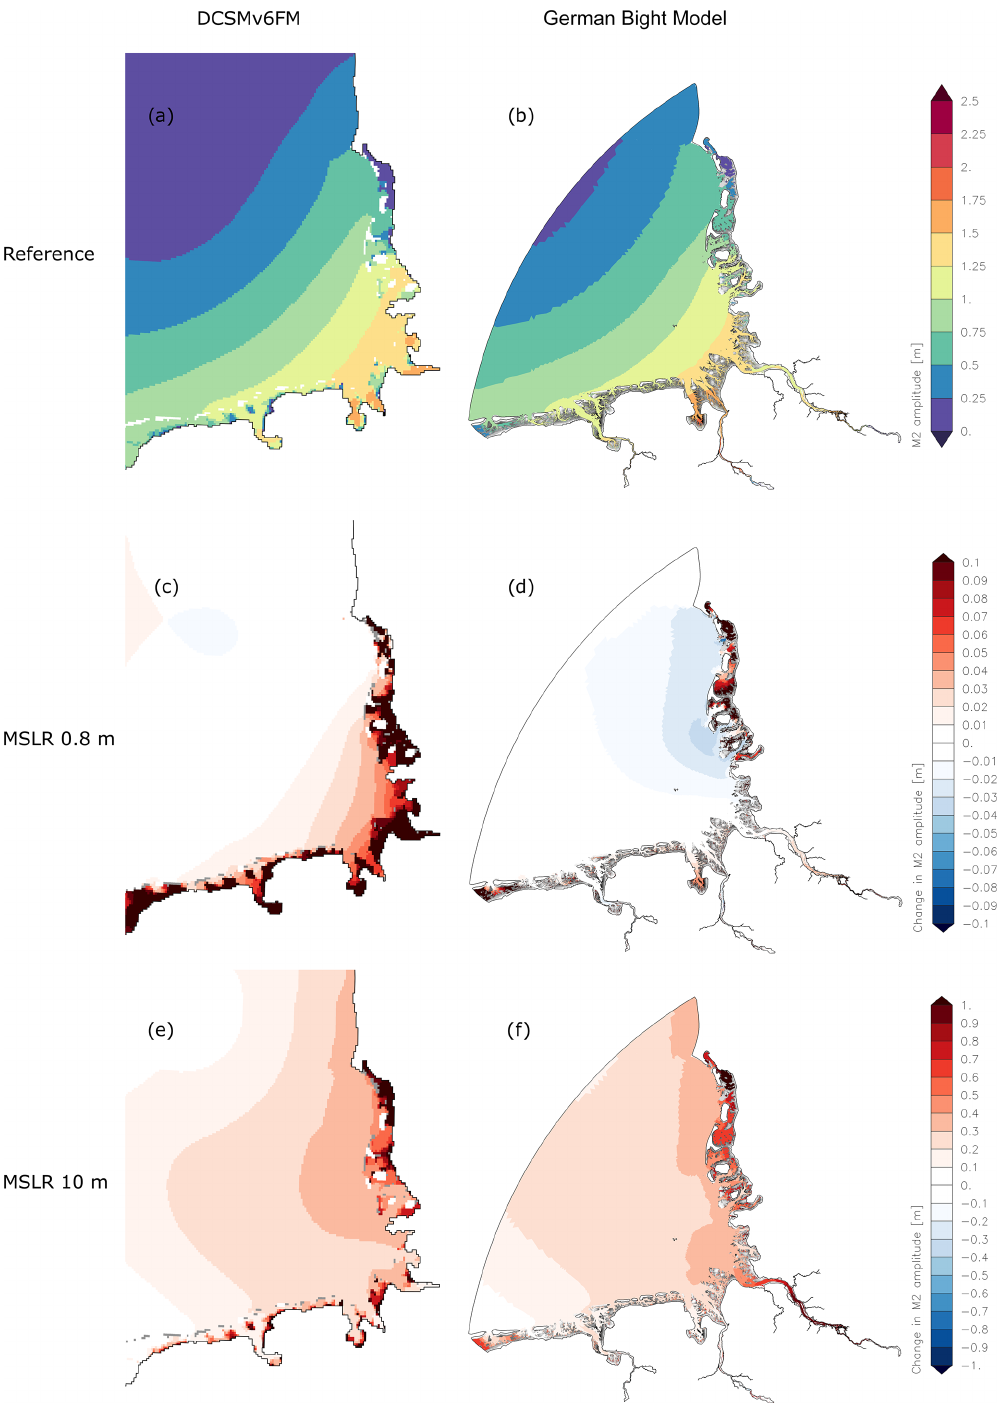
Figure 6. M2 amplitude and response of M2 amplitude to MSLR (increase in red, decrease in blue, dry areas in grey), DCSMv6FM (a, c, e) , German Bight Model (b, d, f) ; first row: reference; second row: MSLR of 0.8 m; third row; MSLR of 10m; (a) Shelf_ref, (b)